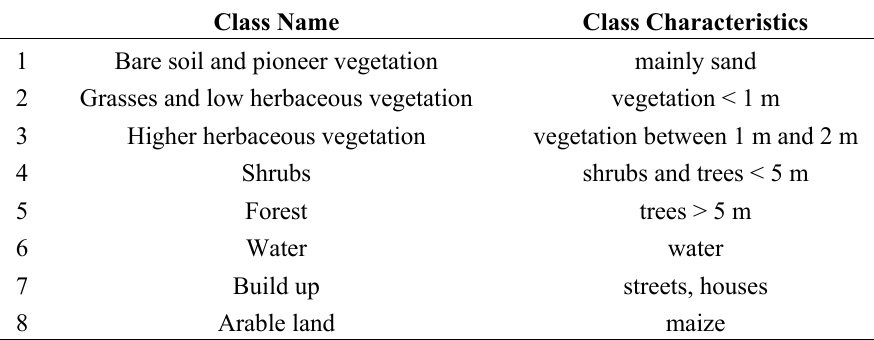
Table 2. Classes used for classification of the CHRIS